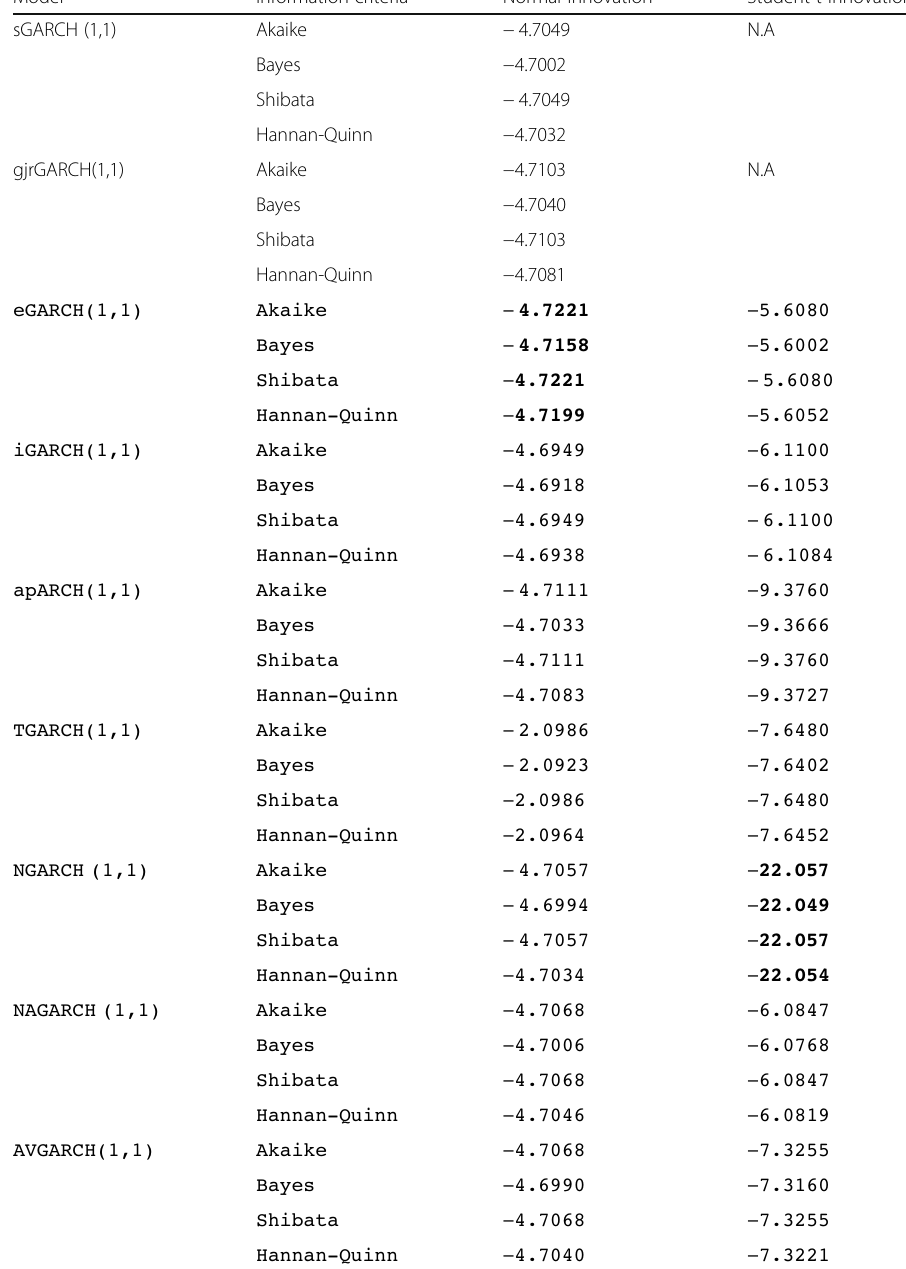
Table 2 GARCH models and their performance on the log returns of daily stock price of Total Nigeria Plc